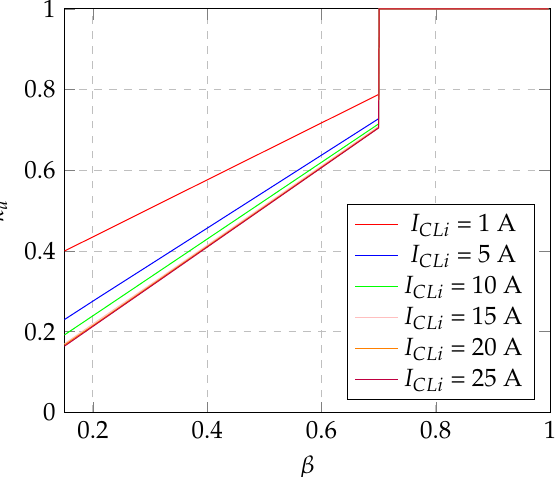
Figure 8. Dependence of the adaptation factor k a on the value of the earth fault coefficient β for different values I CLi